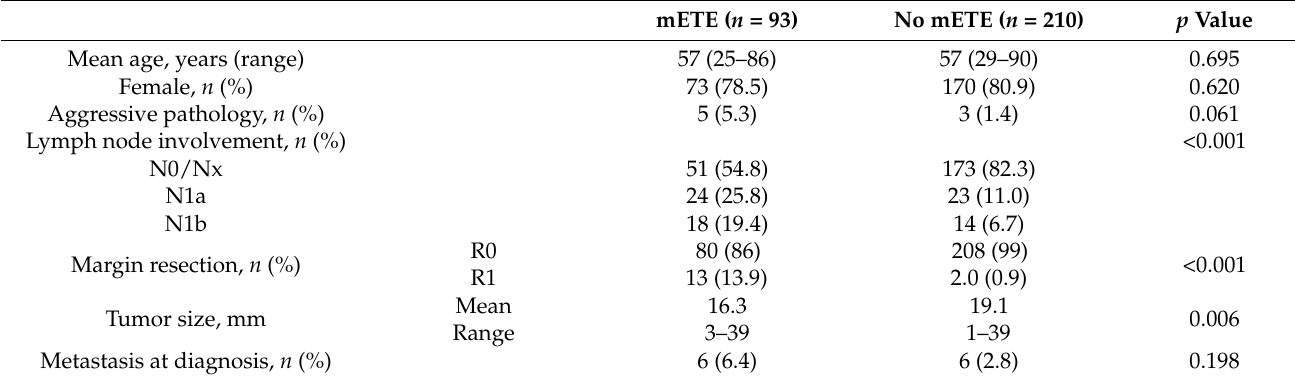
Table 1. Patient characteristics.